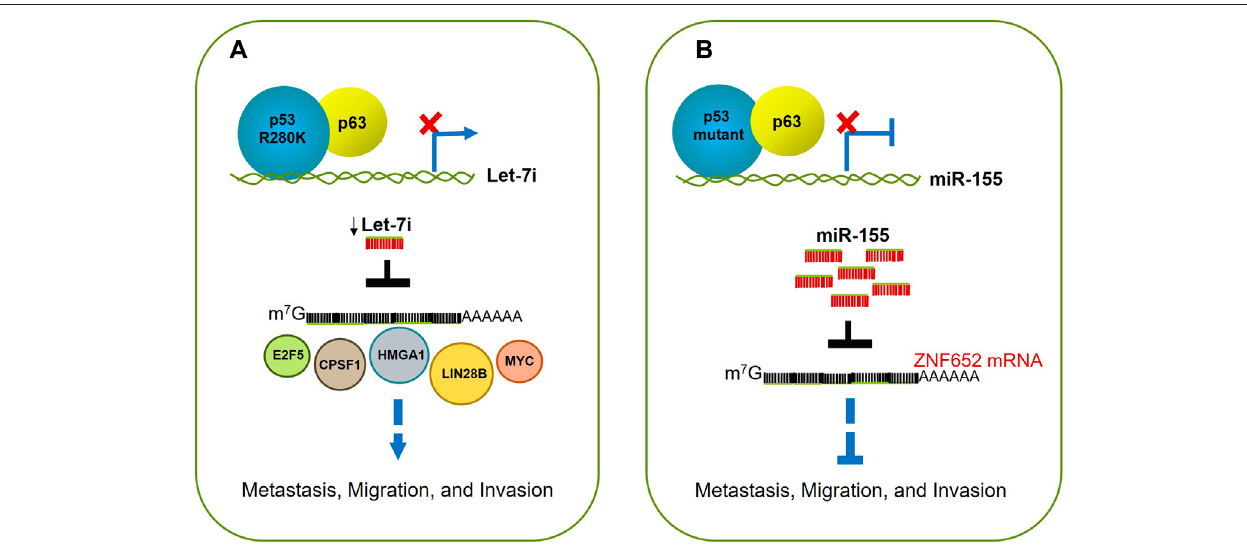
FIGURE 5 | p53 mutants drive migration, invasion, and metastasis. (A) p53R280K associates with p63 blocking its occupancy on let-7i promoter; this leads to downregulation of let7i, and increasing levels of its targets like E2F5, CPSF1, HMGA1, LIN28B, MYC, and NRAS. The alteration of this balance fuels cell proliferation, migration, and invasion. (B) Mutant p53 (p53R248Q or p53R282W) acquires enhanced invasive and metastatic potential through up-regulation of miR-155. This oncomiR promotes invasion by directly repressing the target transcript ZNF652, which as a consequence, causes the acquisition of an invasive cell